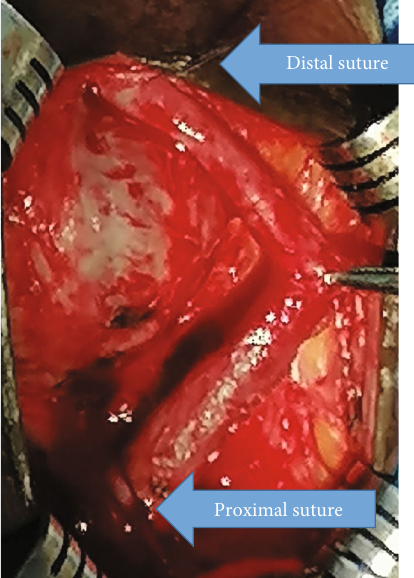
Figure 4: Urethra mobilized completely o ff the ventral surface of the corporeal bodies and rotated 180 ° with the aid of distal and proximal sutures